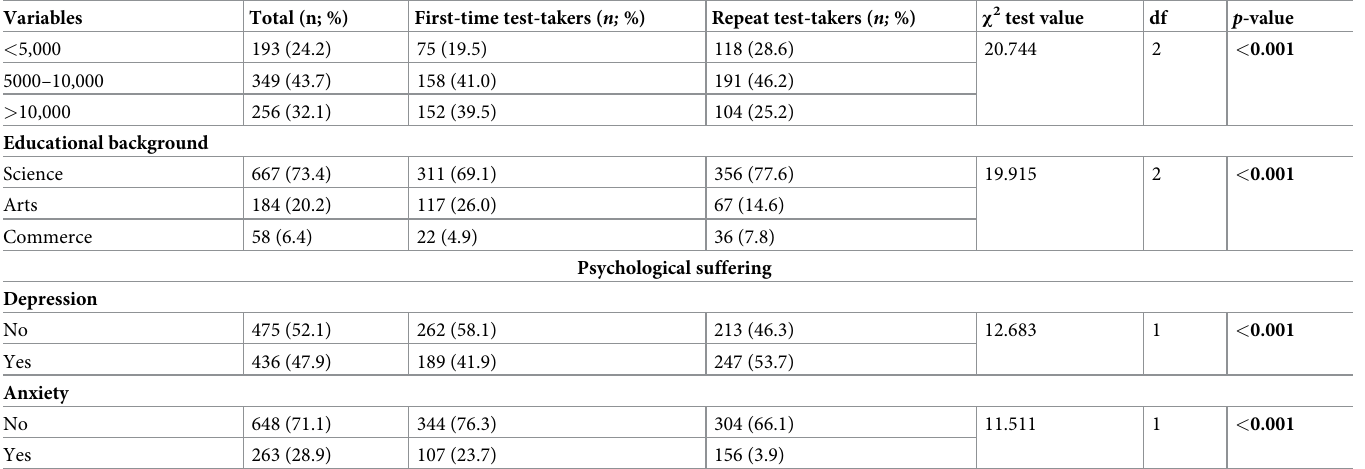
(i.e., 52.2% vs. 43.9%, χ 2 = 6.789, df = 2, p = 0.034), although cynicism (for higher, 74.1% vs. 68.5%, χ 2 = 3.520, df = 2, p = 0.172), and academic efficacy (for lower, 50.7% vs. 47.5%, χ 2 = 1.923, df = 2, p = 0.382) were not significantly associated in terms of student status. About 43.7% (n = 398) and 17.3% (n = 158) of students in the total sample were classified as burnout based on two-dimensional and three-dimensional cutoff scores. Although, the repeat test tak- ers were significantly prone to suffering from two-dimensional burnout (i.e., 48.0% vs. 39.2%; χ 2 = 7.164, df = 1, p = 0.007), three-dimensional did not show any significant relationship across two student groups ( χ 2 = 1.995, df = 1, p = 0.158) ( Fig 1 ).